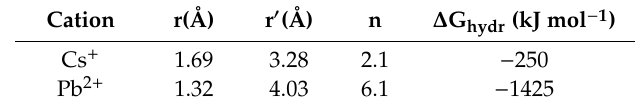
Table 2. Ionic radius and thermodynamic properties of hydrated Cs + / Pb 2 + [25].